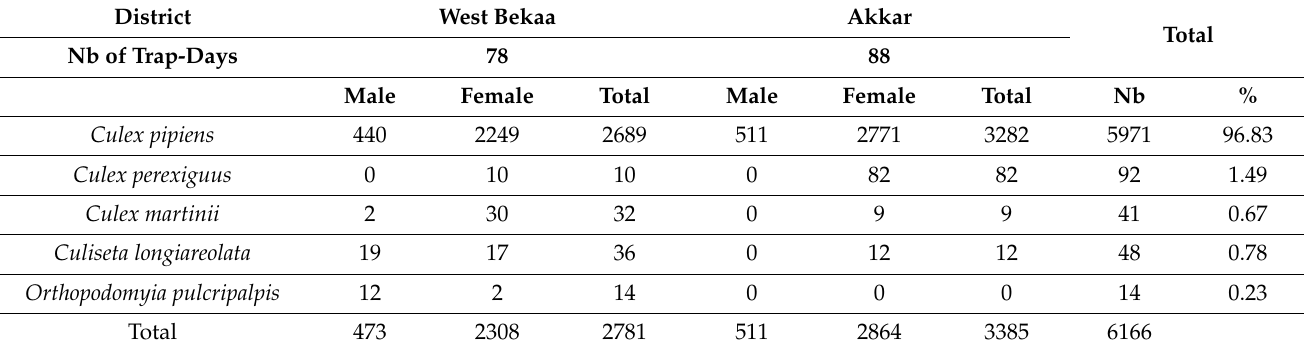
Table 3. Species composition of collected mosquitoes in West Bekaa and Akkar districts during summer 2014.